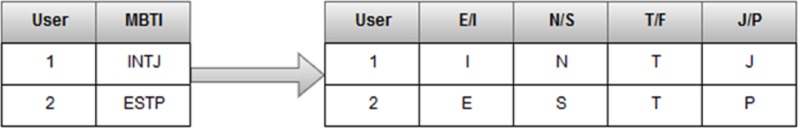
Example of the classifier representation used in TECLA for the MBTI model.